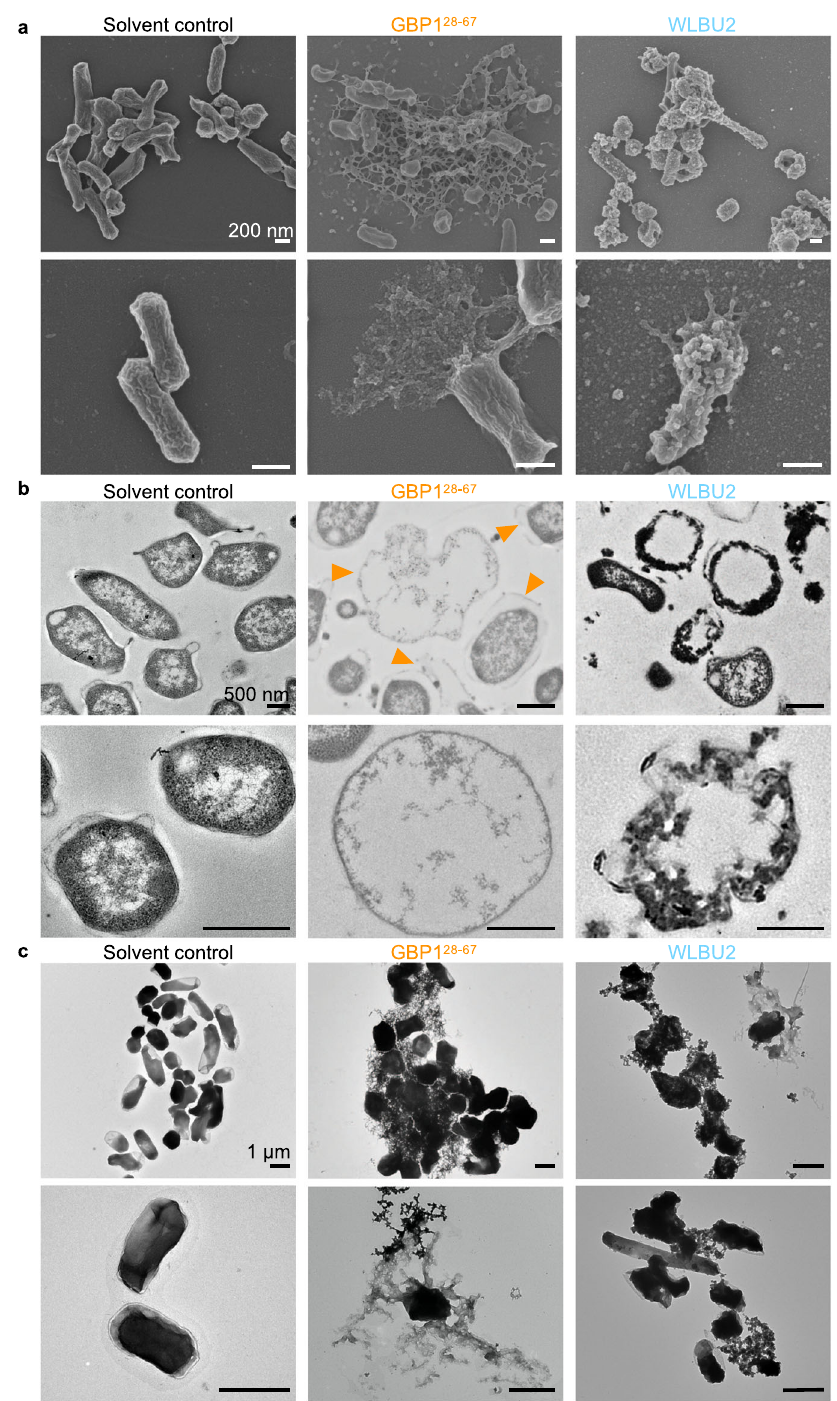
Fig. 4 | GBP1 peptide induces membrane disruption, expulsion of cytoplasmic andmembranouscontentfrom F.novicida .a Scanning electronmicroscopyand ( b )transmissionelectronmicroscopyanalysisofthemorphologyof F.novicida 12h aftertreatmentwithsolventcontrol,100 μ g/mLofGBP1 28 – 67 orWLBU2. c Negative-